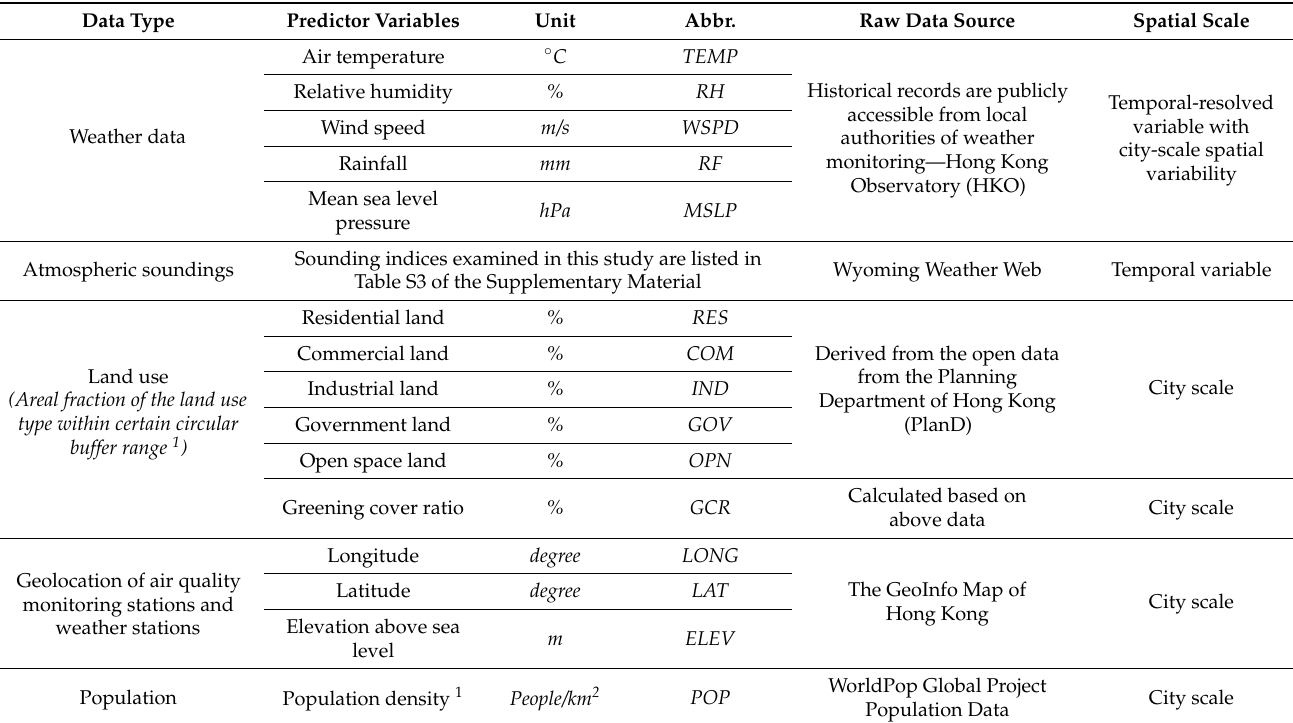
Table 1. Summary of the predictor variables and the corresponding data sources used in the multiscale LUR modeling in the present